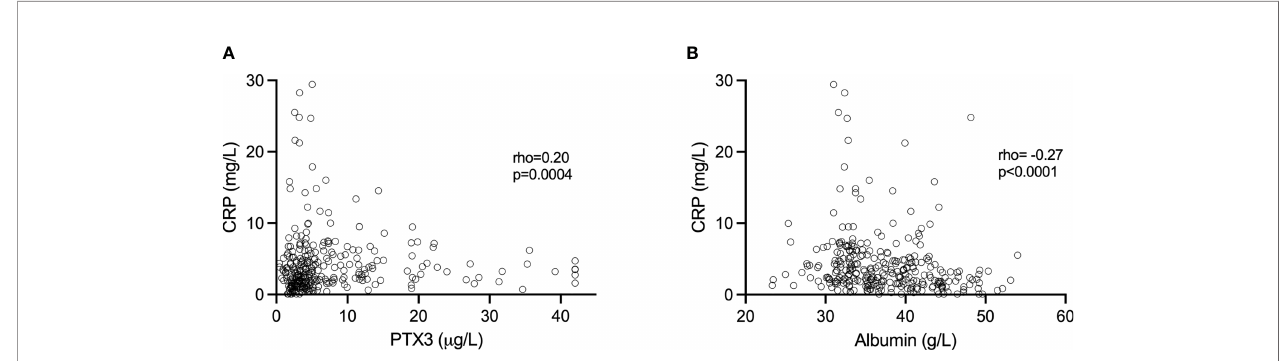
FIGURE 2 | (A) Association of CRP and PTX3 values. (B) Association of CRP and plasma albumin values. Spearman ’ s correlation was used to determine the associations.